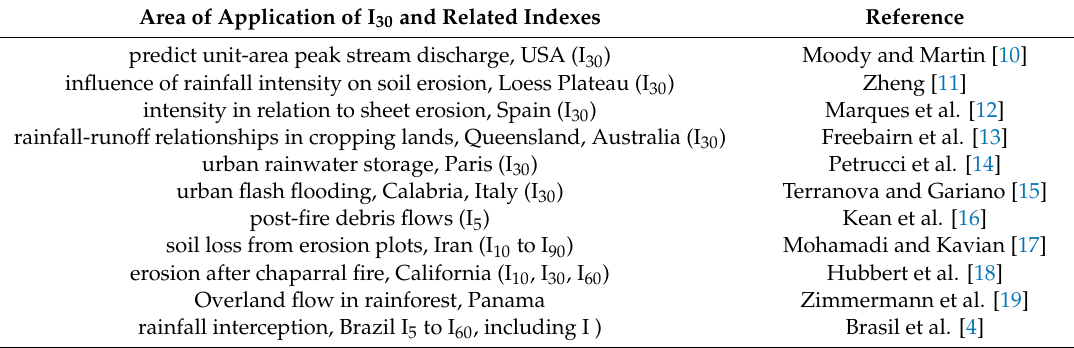
Table 1. Rainfall intensity indexes and their areas of